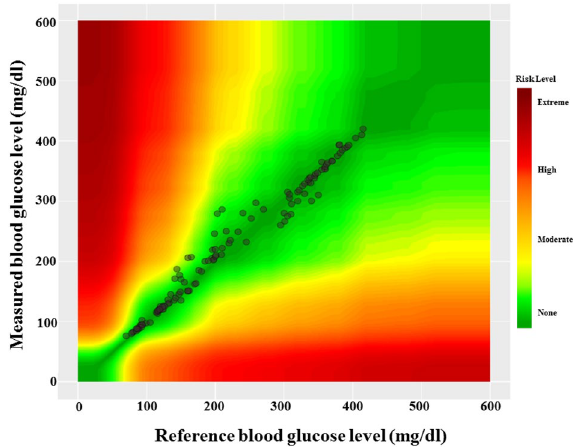
Figure 9. Surveillance error grid analysis for PBGM.